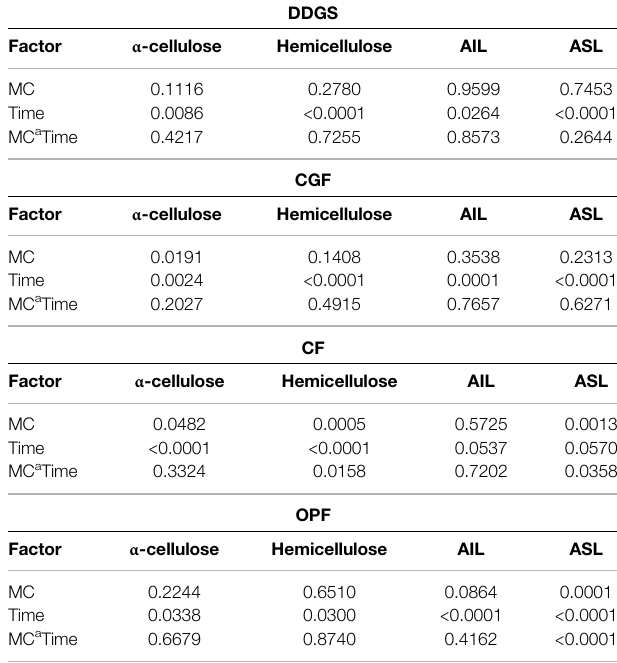
TABLE 2| p -valuesofindividual and interaction effects after LMAA pretreatment a